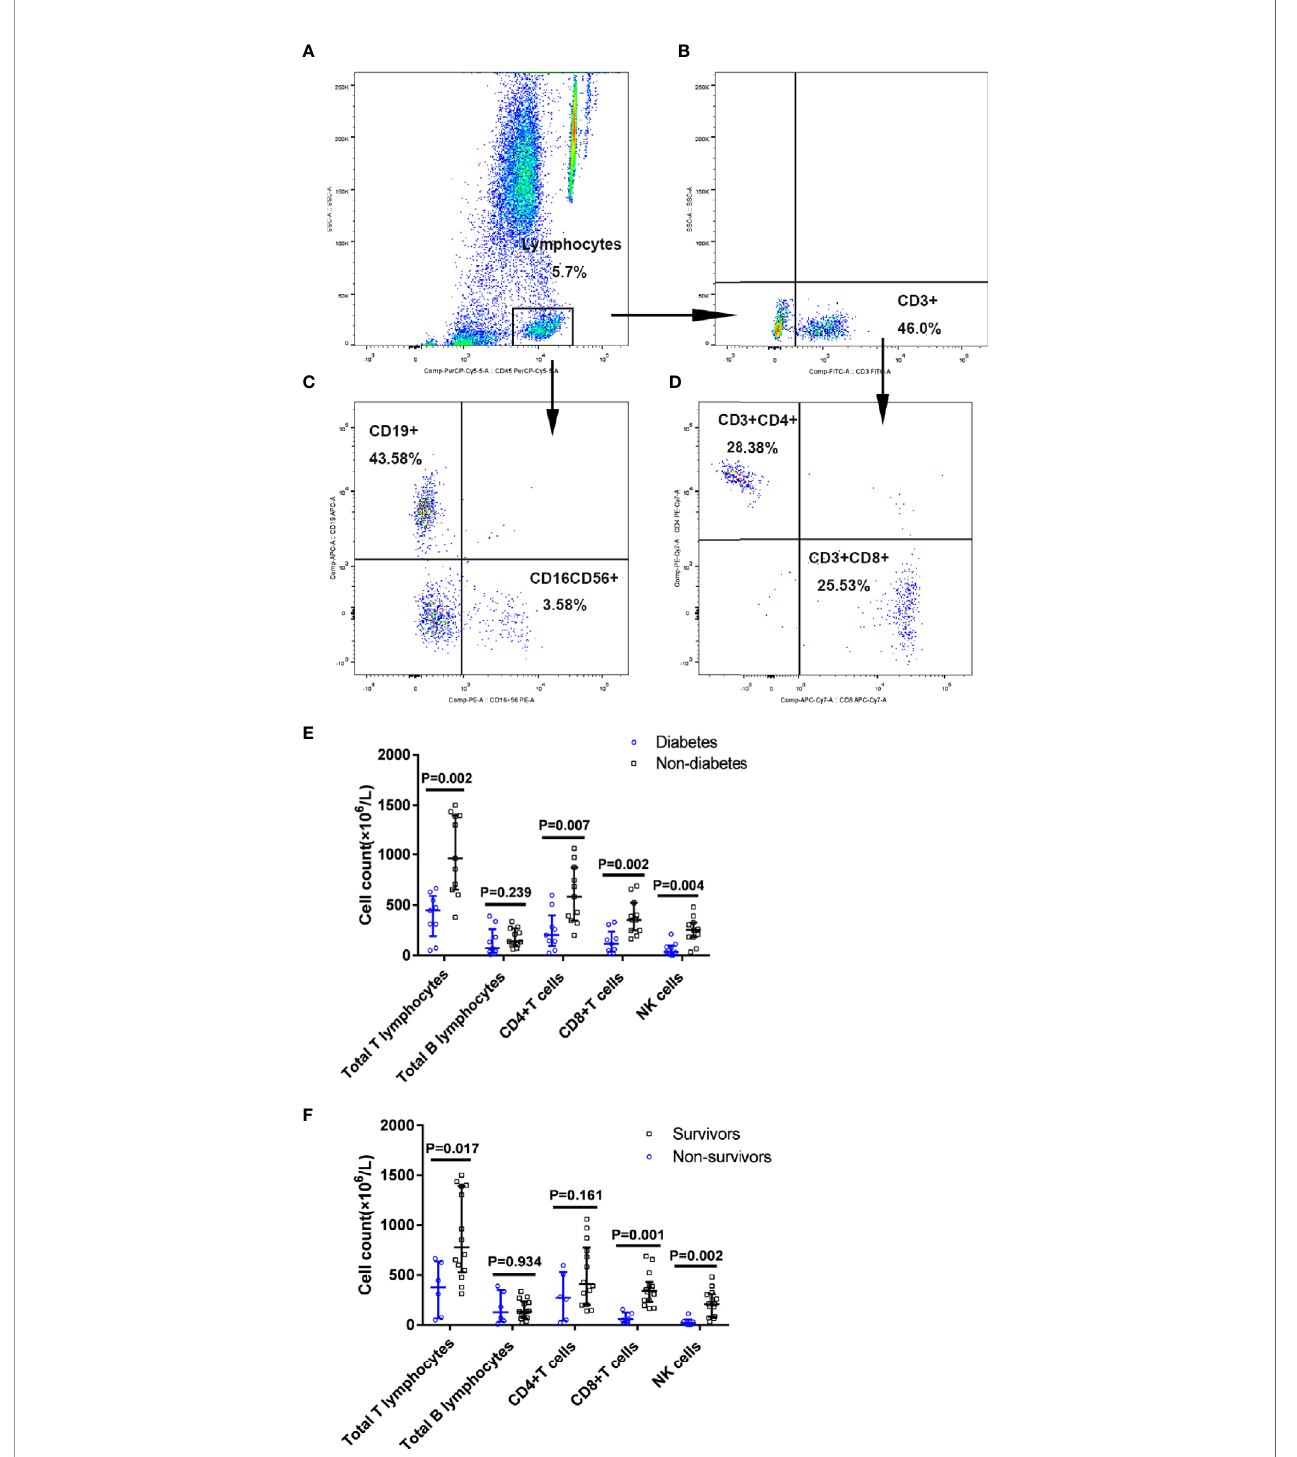
FIGURE 4 | Proportion of immune cells subsets in patients with diabetes with COVID-19. Flow cytometric analysis of B cells, NK cells, CD4+ T cells, and CD8+ T cells from a representative patient (A – D) . A series of comparisons of absolute counts of total T and B lymphocytes, CD4 + T cells, CD8 + T cells, and NK cells between patients with diabetes (n=9) and patients without diabetes (n=11) (E) , as well as between survivors (n=14) and non-survivors (n=6) (F) . All data represent median (IQR). Differences were tested using nonparametric